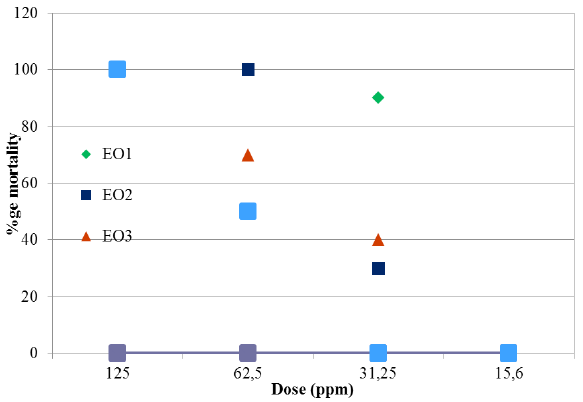
Figure 6: Percent mortality at various dosages of P. heyniae EO1-4 against first instar Ae. aegypti . DMSO was used as solvent